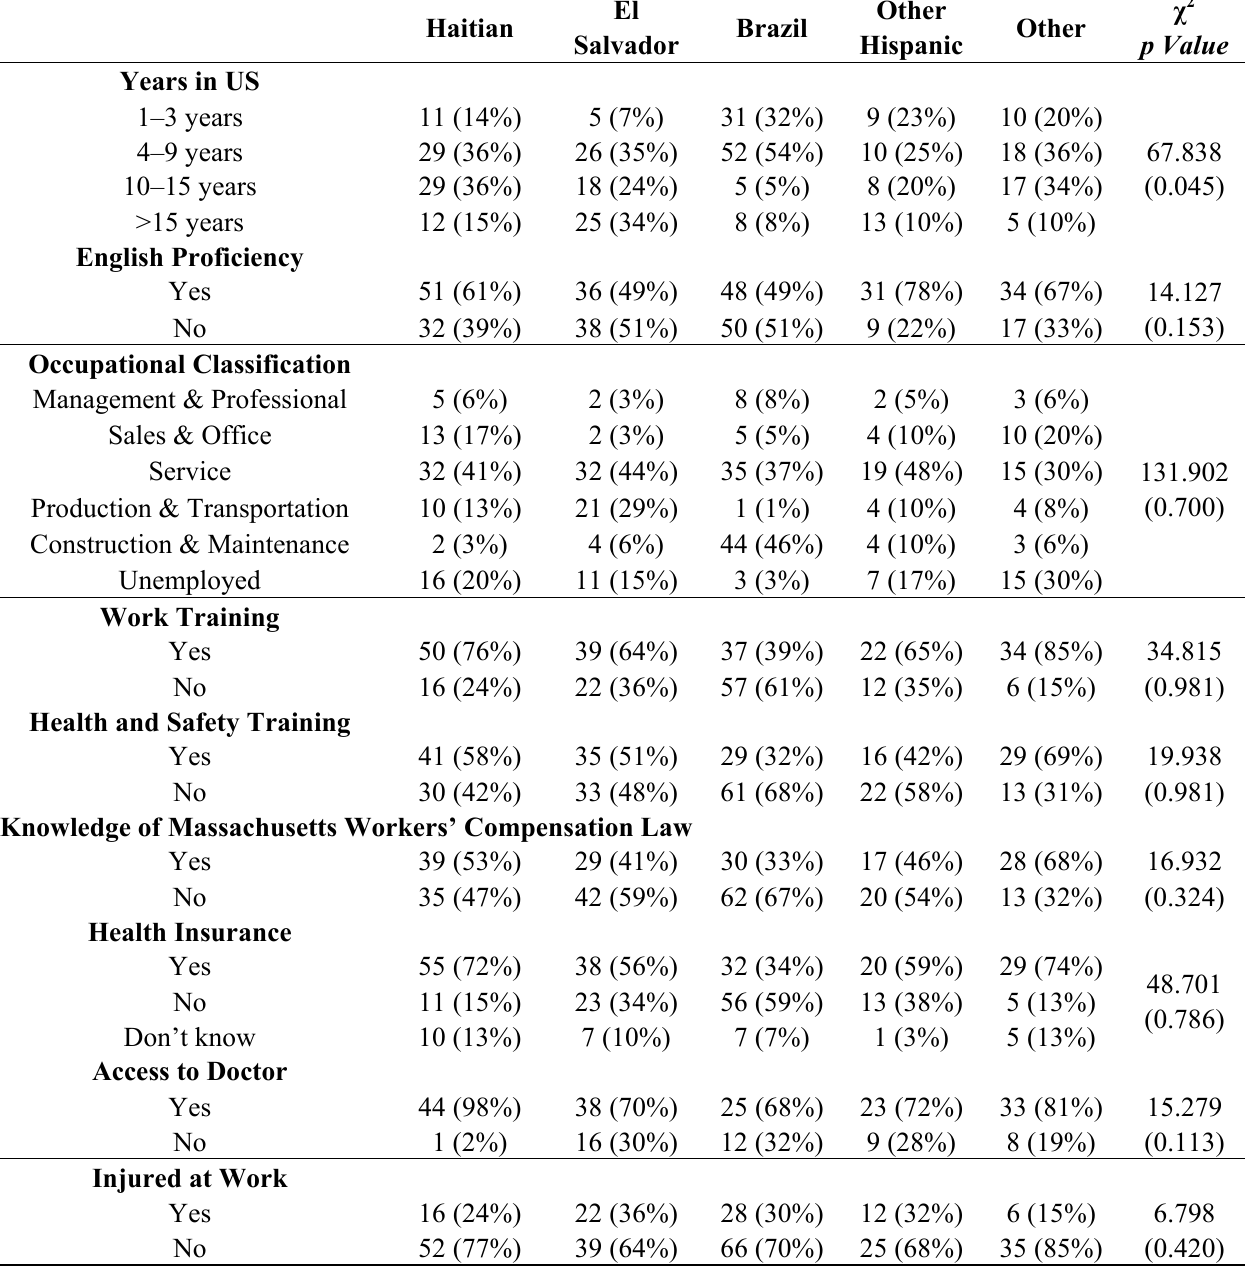
Table 1. Cross-sectional survey results obtained from self-identified immigrant workers, Somerville,